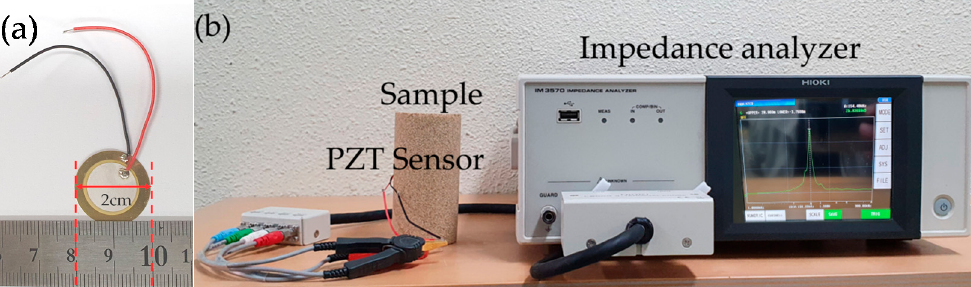
Figure 3. Images of ( a ) the lead zirconate titanate (PZT) sensor and ( b ) the measuring system with the PZT-embedded sample connected to an impedance analyzer.